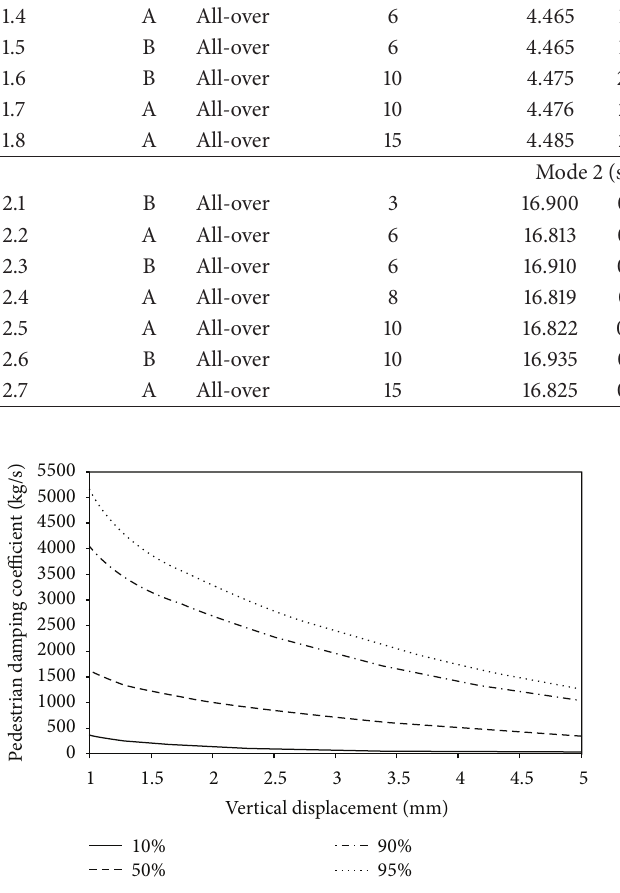
Figure 2: Amplitude-dependent pedestrian damping coefficient for varying probability fractile